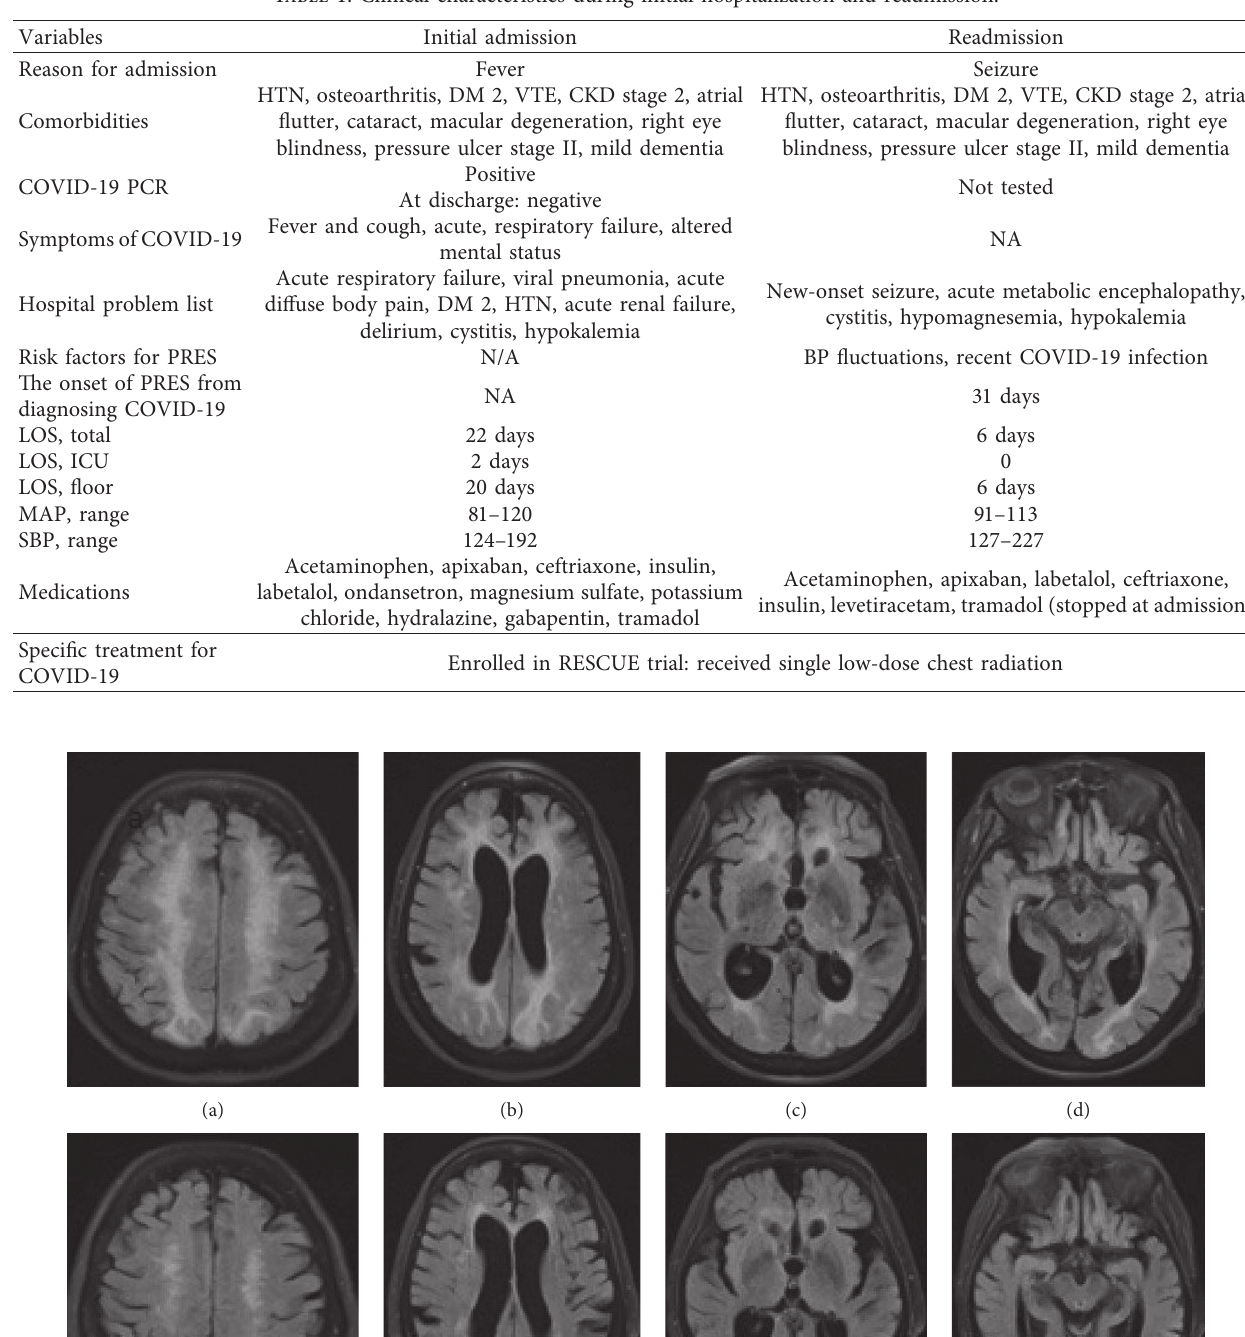
Table 1: Clinical characteristics during initial hospitalization and